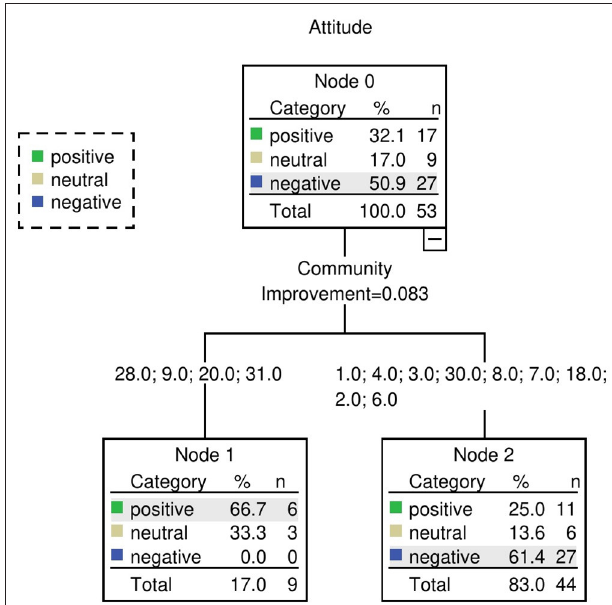
FIGURE 4 | Decision tree of attitudes of households that have faced livestock loss due to tiger in Panna Tiger Reserve.